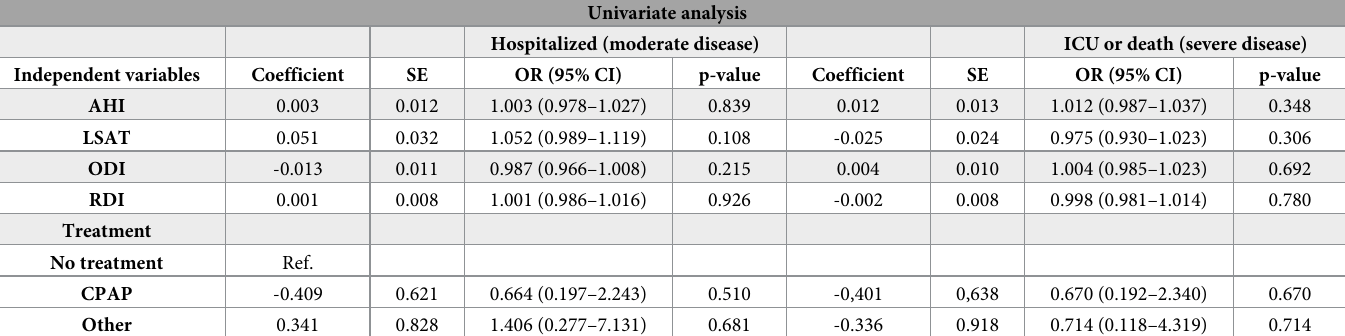
Table 3. Multinomial logistic regression analysis for COVID-19 severity when COVID-19 severity was categorized as non-hospitalized, hospitalized and ICU or